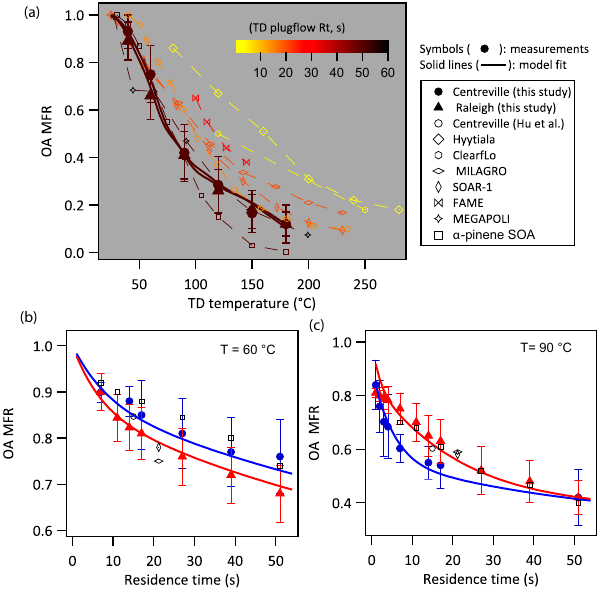
Figure 2. Measured (solid symbols) and modeled (solid, thick lines) campaign-average organic aerosol (OA) mass fraction re- maining (MFR) as a function of TD temperatures ( T ) and res- idence times (Rt). The solid symbol shows mean value and the error bar is ± one standard deviation of all campaign data at each ( T , Rt) condition. Model lines are shown using the best fit volatility parameter values from campaign-average TD data fit (parameter values listed in Table 1). TD measurement data from the Centreville site collected by the University of Colorado group at SOAS-2013 (Hu et al., 2016) are also shown. Mea- surements from several previous field studies are shown with various open symbols: Hyytiala/2008–2010, Finland (Häkkinen et al., 2012); ClearfLo/2012, London (Xu et al., 2016); MILA- GRO/2006, Mexico City (Huffman et al., 2009); SOAR-1/2005, Riverside, California (Huffman et al., 2009); FAME/2008, Fi- nokalia, Greece (Lee et al., 2010); MEGAPOLI/2009–2010, Paris, France (Paciga et al., 2016). Chamber α -pinene SOA (dark ozonoly- sis, C OA ∼ 5µgm − 3 , VMD ∼ 140nm) evaporation data are shown from Saha and Grieshop (2016). In panel (a) , data are color coded by TD residence times used during measurements. The legend shown next to panel (a) applies to all panels (a–c)